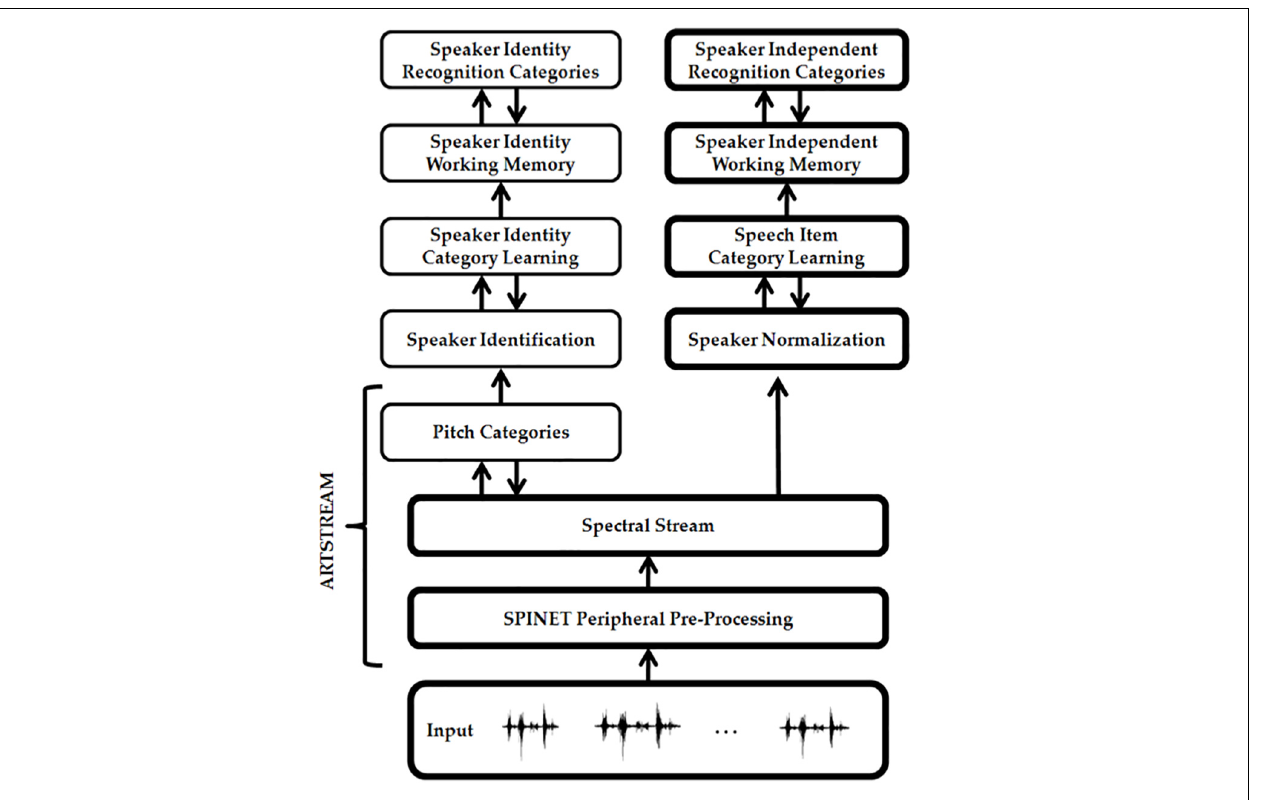
FIGURE 3 | The ARTSPEECH architecture. ARTSPEECH consists of two parallel cortical processing streams, one devoted to speaker identification and the other to speaker meaning. Speaker identification can be learned from a speaker-dependent and rate-dependent representation of speech prosody. Speaker meaning can be learned from a speaker-normalized and rate-normalized representation of speech Item-Order-Rank information. Both streams process their distinct representations in working memories and reciprocally interact with chunking networks of similar design. [Reprinted with permission from Ames and Grossberg